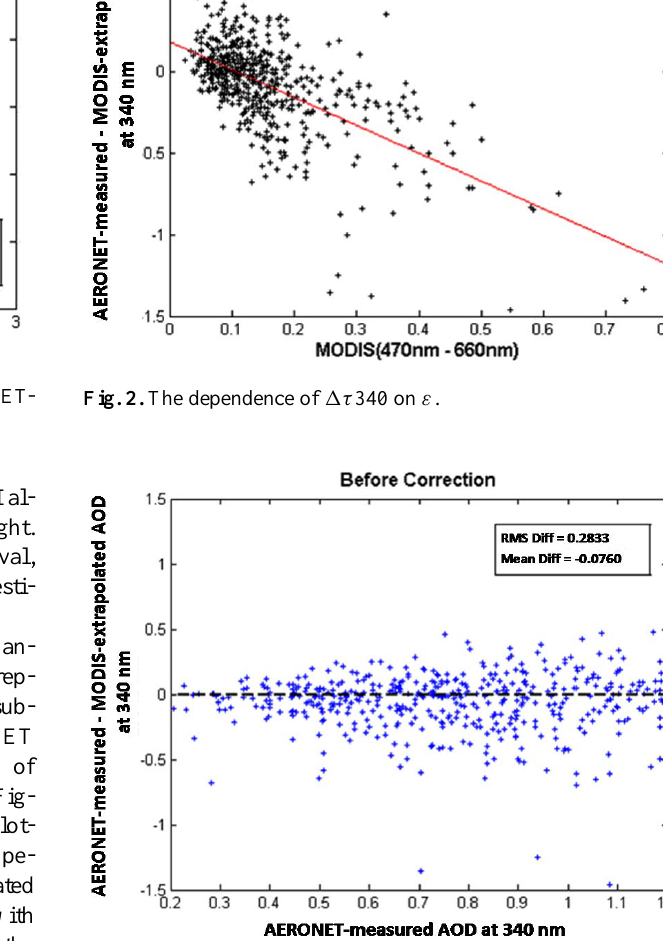
Fig. 3. The 1τ 340 versus AERONET-measured AOD at 340nm (a) before correction, and (b) after